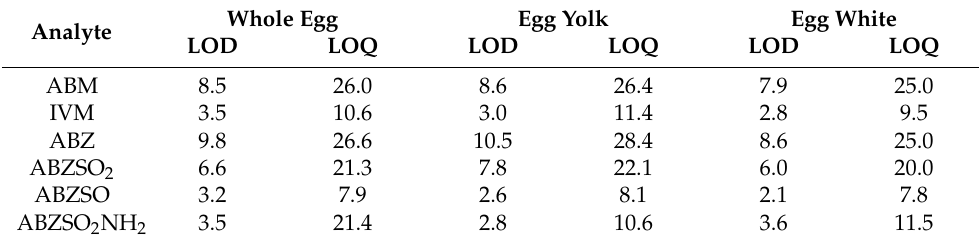
Table 2. LODs and LOQs of six target compounds in eggs ( µ g/kg).